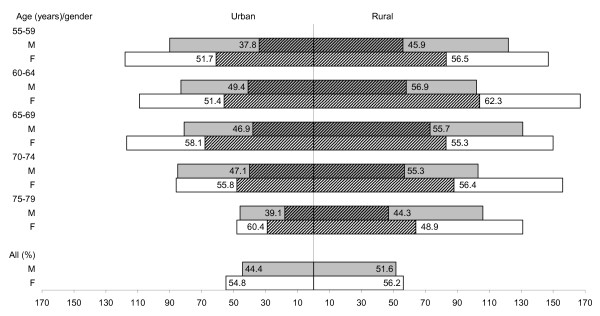
Participants (n = 1146) by municipality, gender and age (%) (shaded areas). Total bars correspond to sample size in strata.